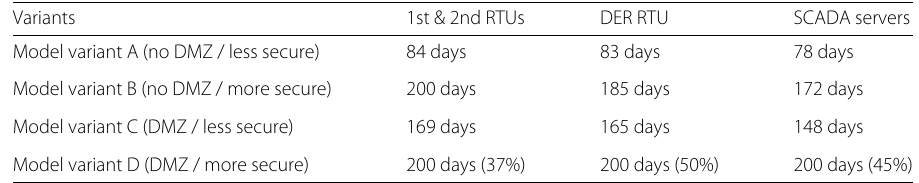
Table 4 Analysis results with an attacker positioned on a Smart Meter Variants 1st & 2nd RTUs DER RTU SCADA servers Model variant A (no DMZ / less secure) 84 days 83 days 78 days Model variant B (no DMZ / more secure) 200 days 185 days 172 days Model variant C (DMZ / less secure) 169 days 165 days 148 days Model variant D (DMZ / more secure) 200 days (37%) 200 days (50%) 200 days (45%)